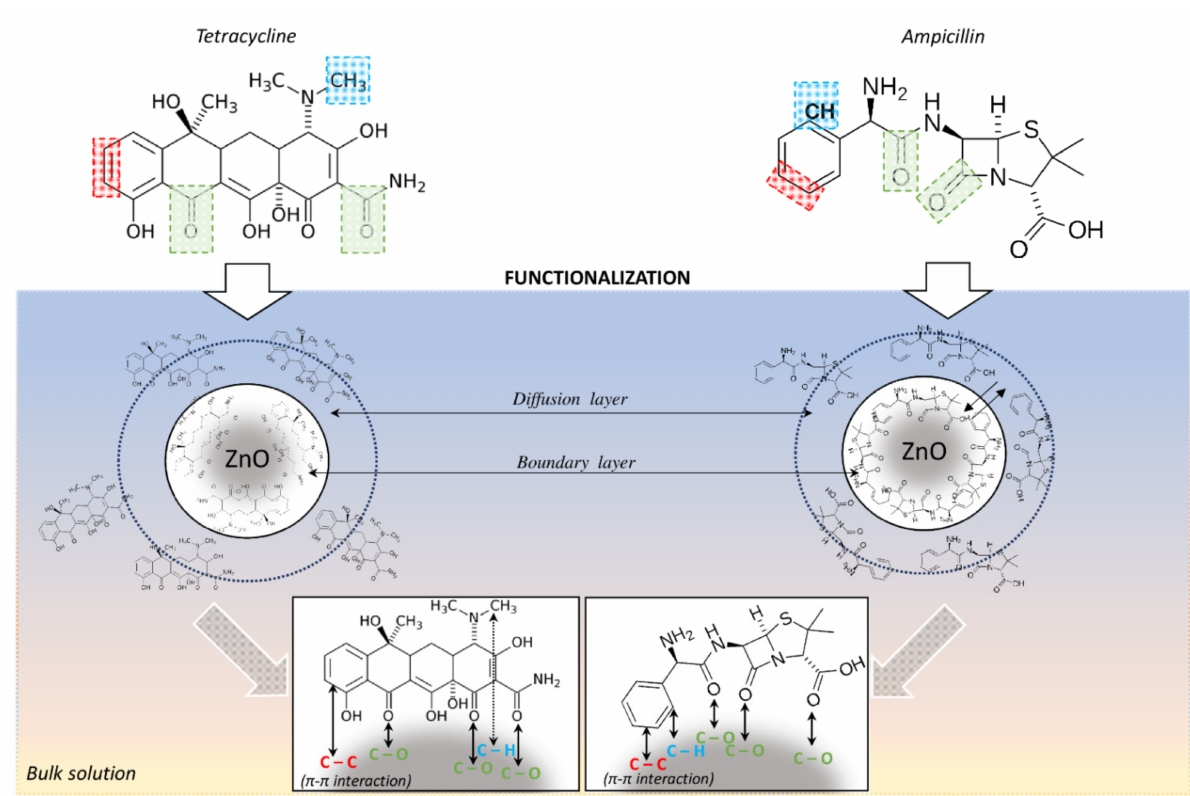
Figure 5. Proposed mechanism of ampicillin and tetracycline binding on the surface of ZnO NPs, where green, blue and red color mark the functional groups of the antibiotics that participate in their interaction with the surface of